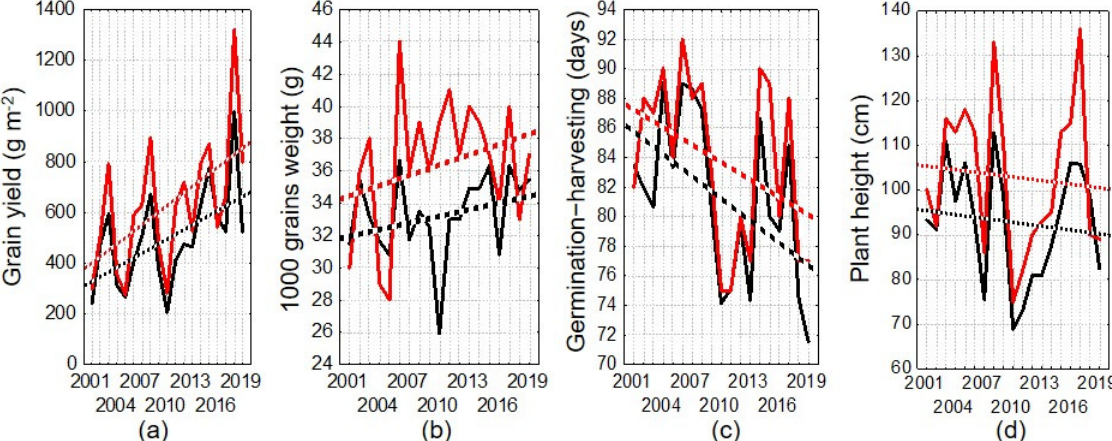
Figure 2. Dynamics of mean values across the studied set of oat accessions: ( a ) grain yield; ( b ) 1000 grain weight; ( c ) length of the germination to harvesting period; ( d ) plant height. Designations: black graphs are for the collection’s mean values; red graphs are for cv. ‘Gorizont’.